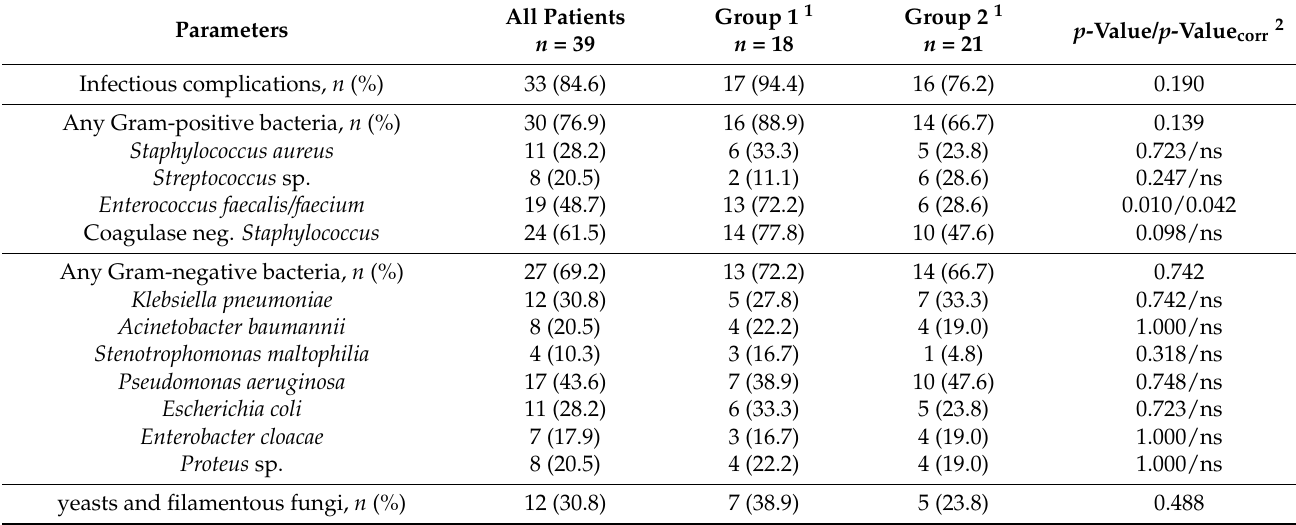
Table 2. A general overview of infectious complications in patients with toxic epidermal necrolysis (TEN) in the context of the use of antibiotics (ATB) before TEN